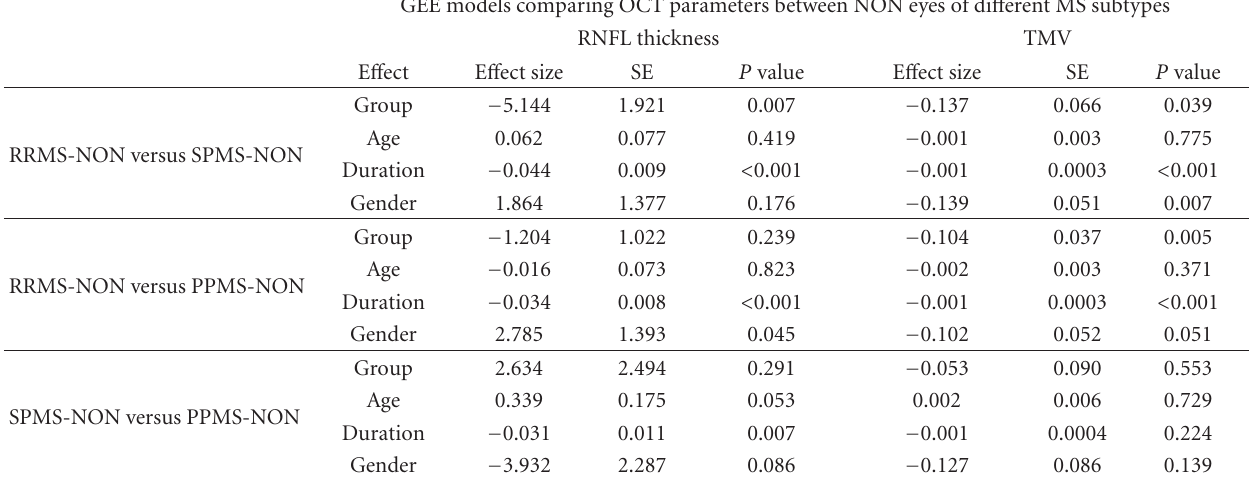
Table 4: Di ff erences between MS subtypes without a history of optic neuritis (NON) were analyzed with generalized estimation equations (GEE) models including age, disease duration, and gender as e ff